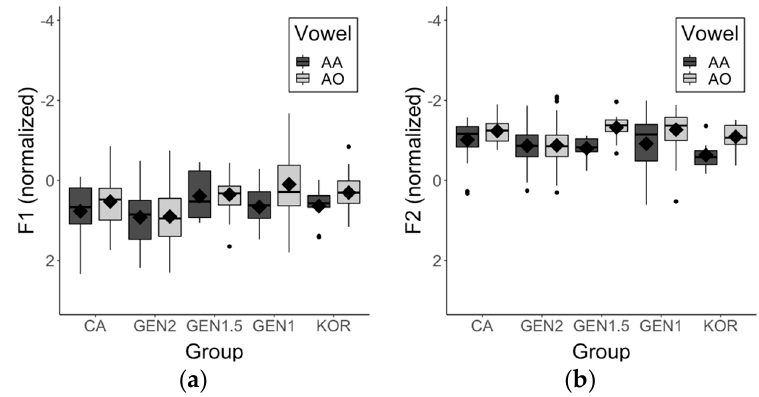
Figure 6. AA and AO across groups: ( a ) Normalized F1; ( b ) Normalized F2.